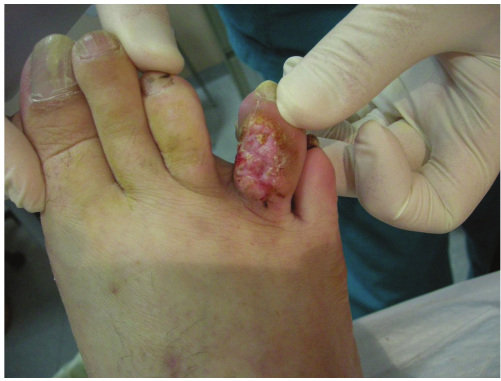
Figure 1: Granular cell tumor of the forth toe of the right foot.